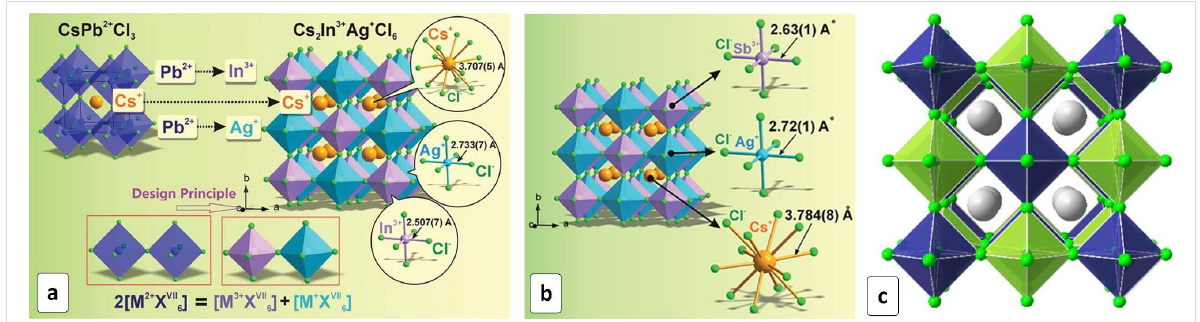
Figure 15: (a) Evolution of the crystal structure from CsPbCl 3 to Cs 2 AgInCl 6 HP; (b) Crystal structure of Cs 2 AgSbCl 6 HP; (c) Crystal structure of Cs 2 AgBiCl 6 HP; Cs + ions are presented as gray spheres and Cl – as green spheres, the Ag and Bi centered octahedra are shown as blue and green ones, respectively. (a) Reproduced with permission from [179], copyright 2017 The Royal Society of Chemistry; (b) Reproduced with permission from [190], copyright 2018 The Royal Society of Chemistry; (c) Reprinted with permissions from [180], copyright 2016 American Chemical Society.